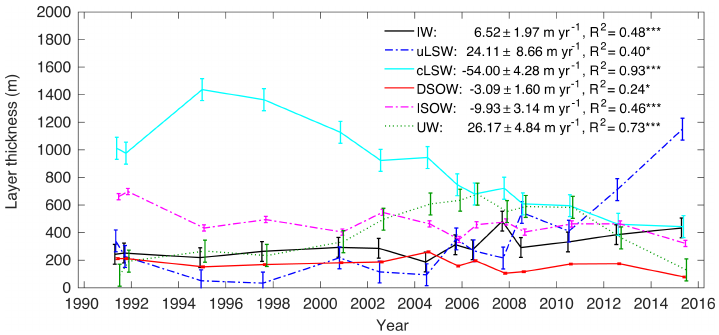
Figure 7. Layer thickness for IW, uLSW, cLSW, DSOW, ISOW and the sum over the upper ocean waters (UWs) based on Irminger Sea cruise data from 1991–2015. The mean depth between 40.5 and 31.5 ◦ W is 2650m. The error bars show the uncertainty based on a Monte Carlo simulation scaled to the width and depth of the Irminger Sea. The rates of thickness change between 1991 and 2015 are given for all SWTs, including the R-squared value of the linear regression model. Significance at the 90% level ( ∗ ) or the 99% level ( ∗∗∗ ) is indicated. Values of the two cruises in 1997 were averaged and are shown as one data point. All markers are slightly offset in time for clarity.